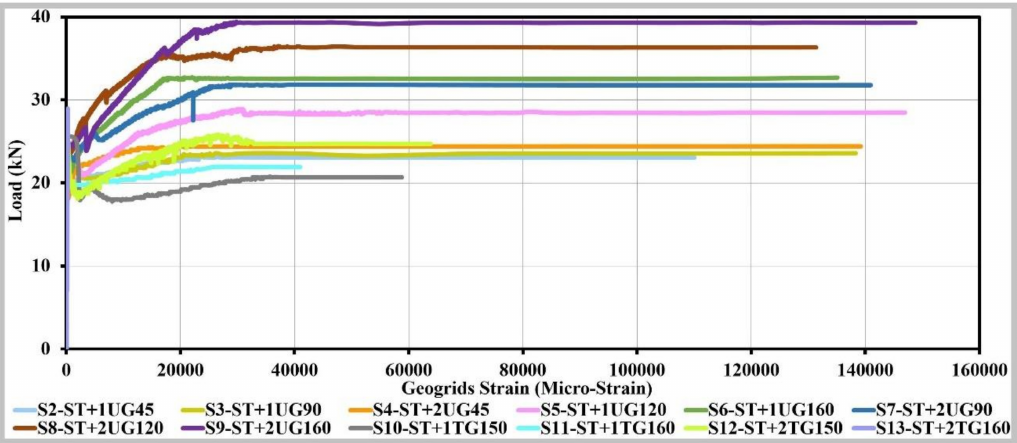
Figure 16. The load-strain curves of